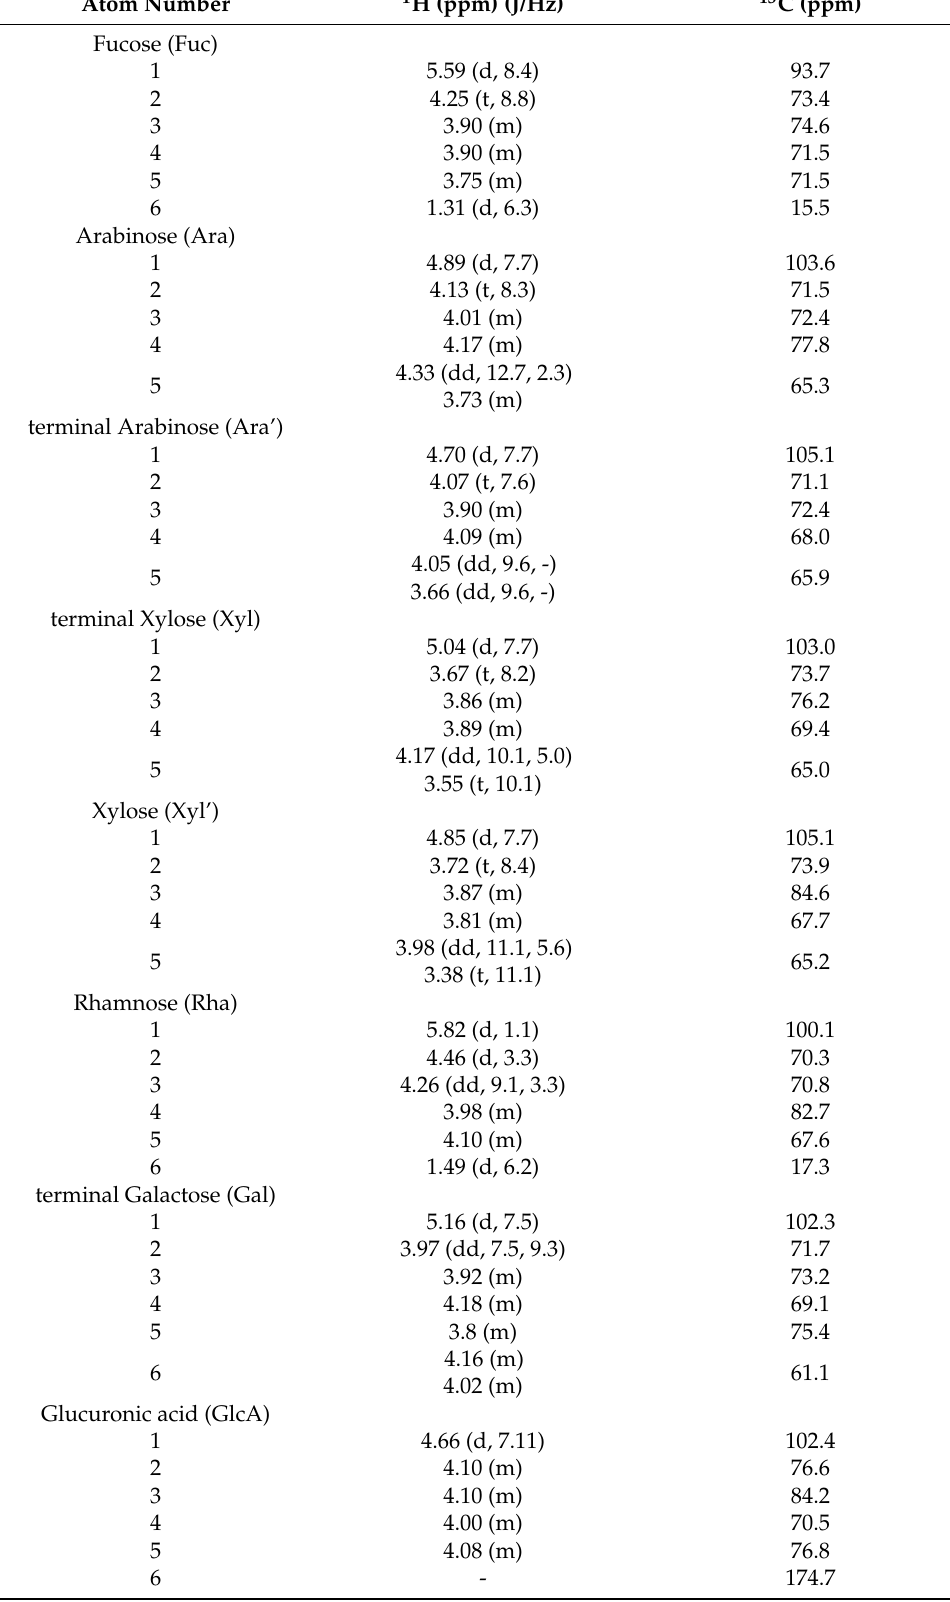
Table 2. 1 H and 13 C data (ppm) for the sugar moieties in GOTCAB; 1:1 pyridine_d5/D 2